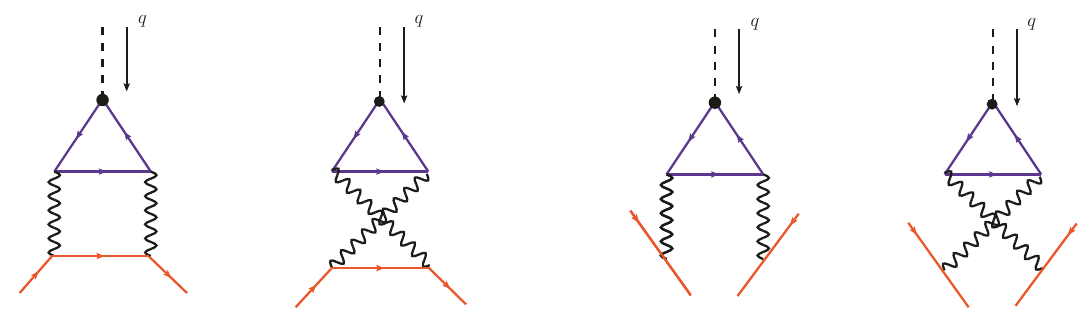
Figure 1. Two-boson exchange diagrams for interactions between a scalar or pseudo-scalar boson and one or two external fermions, φ ( q ) ¯ ψ ( p 0 ) Λ ψ ( p ) ( Λ S = 1 and Λ P = γ 5 ), via a lepton triangle S/P loop. Two diagrams on the left: one-body two-loop interactions. Two diagrams on the right: two-body one-loop